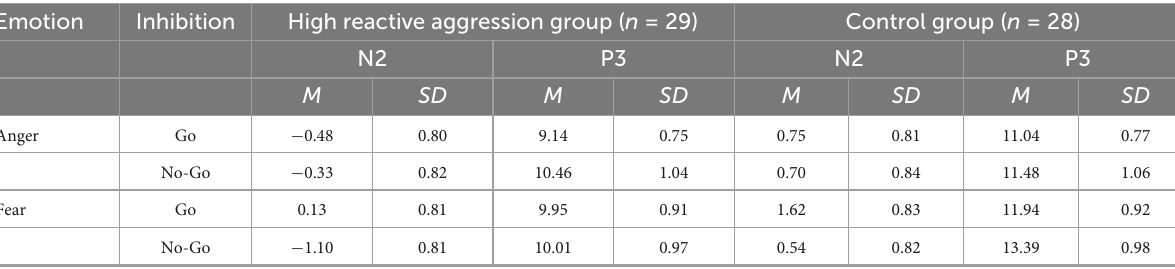
TABLE 2 N2 and P3 amplitudes during the emotional Go/No-Go task by the group.